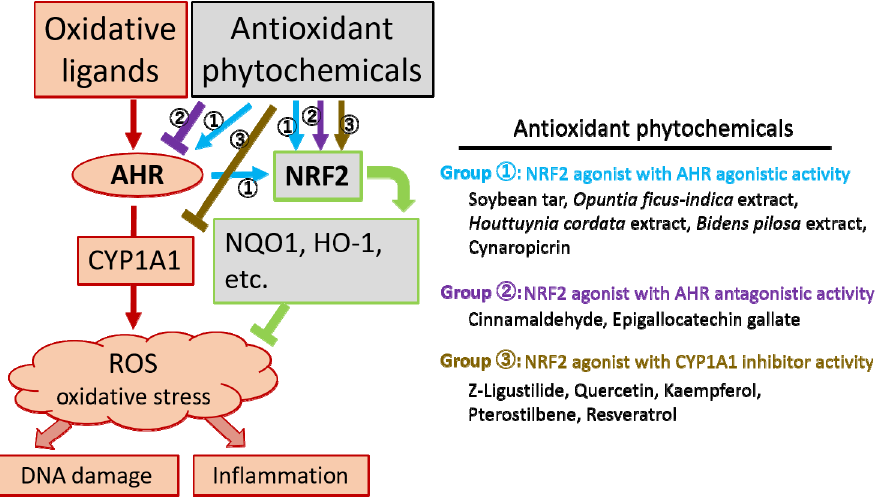
Figure 3. Antioxidant phytochemicals differentially modulate aryl hydrocarbon receptor (AHR), cytochrome P450 1A1 (CYP1A1) and nuclear factor ‐ erythroid 2 ‐ related factor ‐ 2 (NRF2). Oxidative